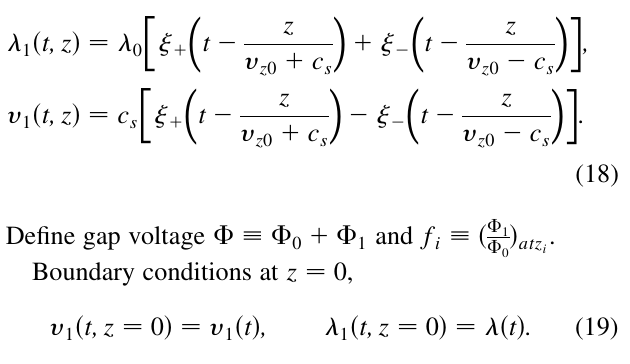
FIG. 10. Setup for the two-step